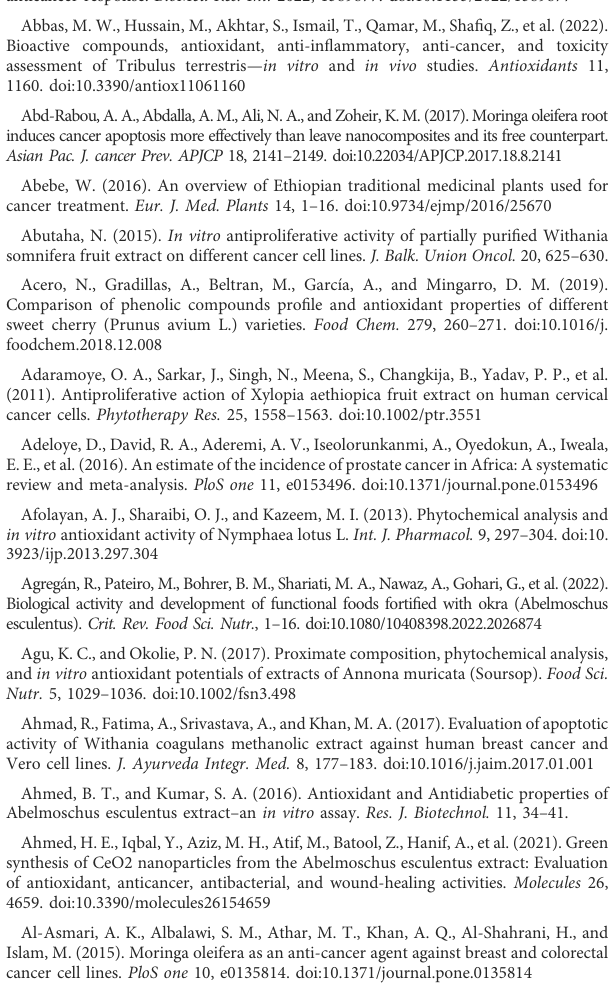
Figure 2 summarize the different pathways on which different plants their compounds and